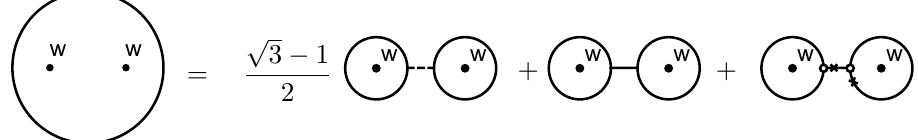
Figure 59 . An example of a crossing equation that constrains the lassoing of bulk operators. On the right, we have dropped the contribution from the H-junction with the identity line in the middle, because b Y annihilates the bulk operator w